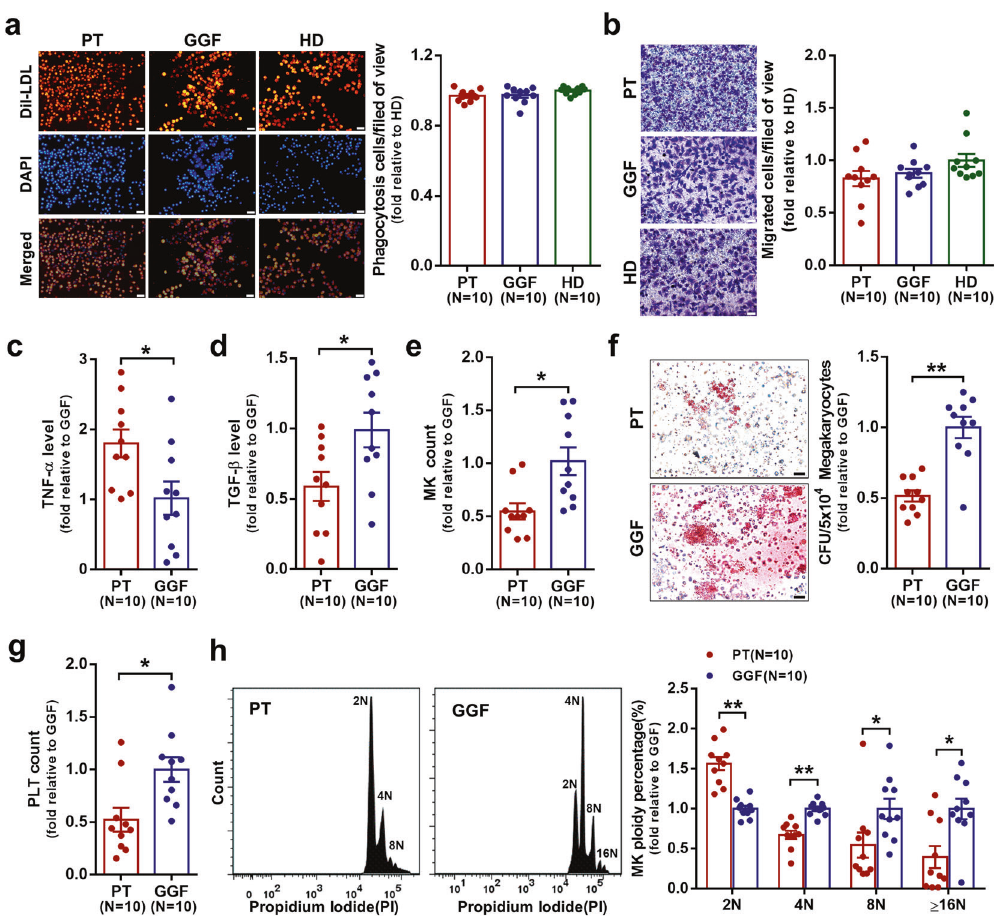
Fig. 2 Increased M1 macrophages and decreased M2 macrophages lead to a reduced megakaryopoiesis-supporting ability in the bone marrow of PT patients. a Representative images (left panel, scale bars represent 50 μ m) and quanti fi cation (right panel) of the phagocytosis assays for the cultivated BM M Ф s from PT patients, GGF patients and HD after 7 days in culture. b Representative images (left panel, scale bars represent 50 μ m) and quanti fi cation (right panel) of the transwell migration assays for the cultivated BM M Ф s from PT patients, GGF patients, and HD after 7 days in culture. The intracellular levels of c TNF- ɑ and d TGF- β were analyzed in BM M Ф s from PT patients and GGF patients after 7 days of culture. MK production and maturation, colony-forming unit MK (CFU-MK) plating ef fi ciencies, and platelet release were analyzed after coculture with the cultivated BM M Ф s from PT patients and GGF patients. The e MK count, f CFU-MK count (left panel: representative images, scale bars represent 50 μ m; right panel: quanti fi cation), g platelet count and h MK ploidy distribution were analyzed after 12 days of coculture. Data are presented as the means ± SEM (* P ≤ 0.05, ** P ≤